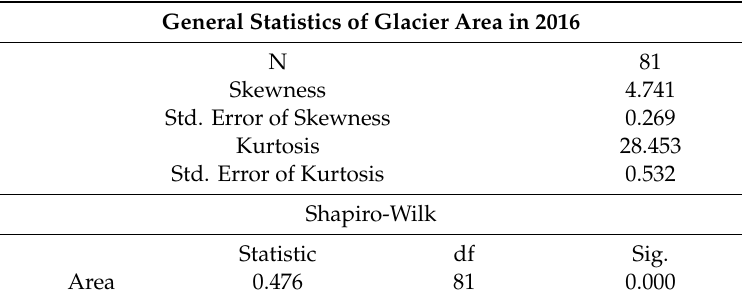
Table 3. Tests of Normality of glacier